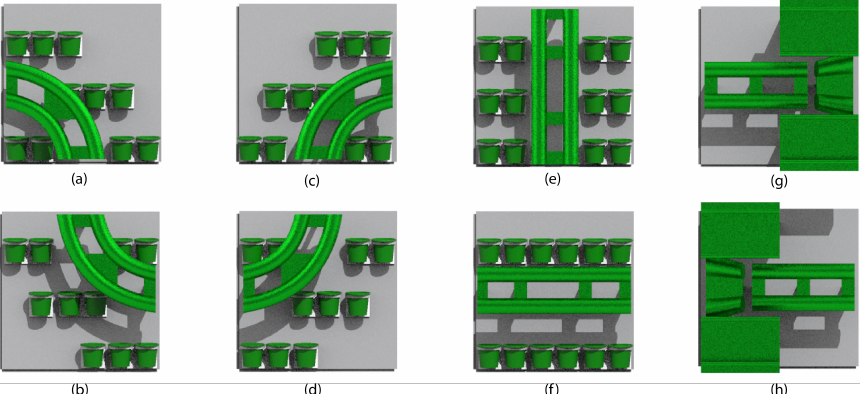
Figure 6. ( a ) SW bend tile, ( b ) NE bend tile, ( c ) SE bend tile, ( d ) NW bend tile, ( e ) vertical track, ( f ) horizontal track, ( g ) East track end, ( h ) West track